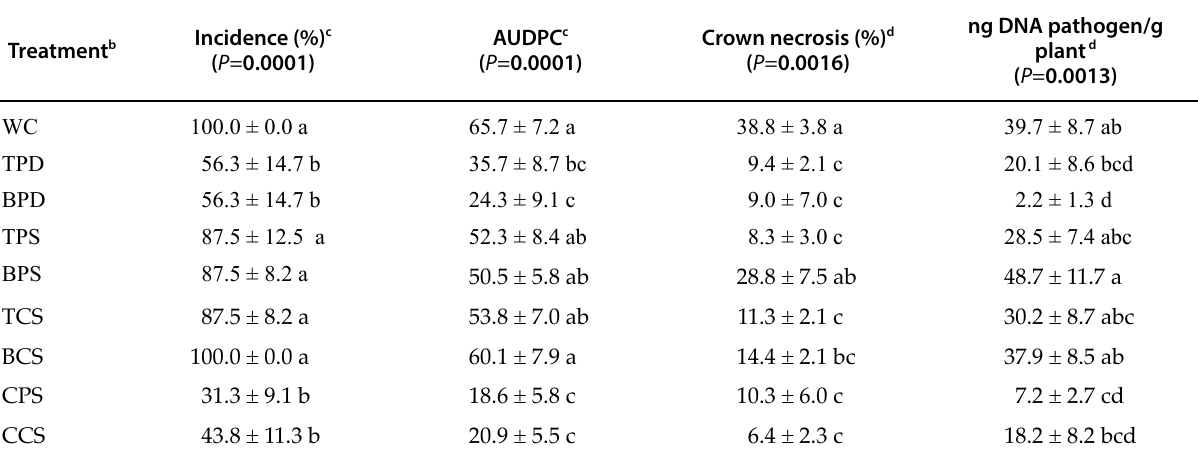
Table 2 . Means of disease incidence, AUDPC, proportions of crown necrosis and amounts of pathogen DNA in plant tis- sues, after application of different biological and chemical treatments for control of charcoal rot caused by Macrophomina phaseolina in ‘Fortuna’ strawberry plants grown in growth chamber conditions a